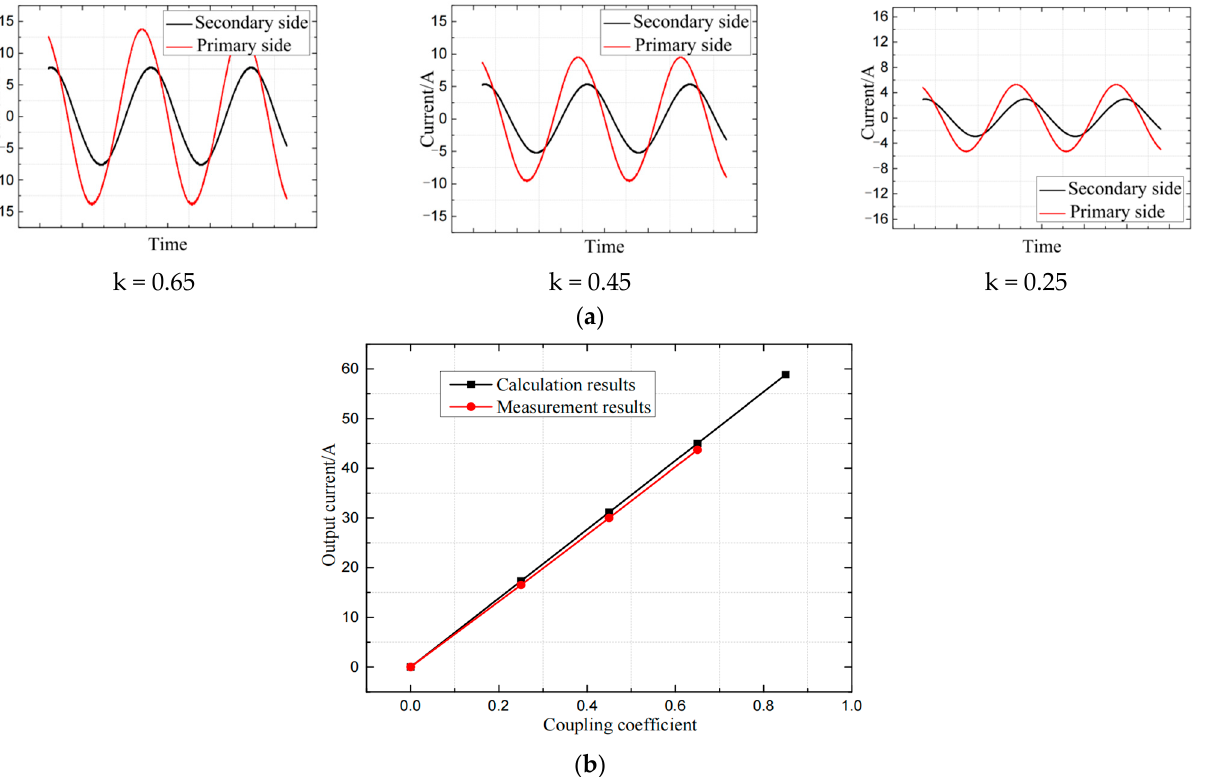
Figure 25. Comparison of experimental waveforms and theory in the case of misalignment: ( a ) Current of primary and secondary coils under different coupling coefficients; ( b ) output current comparison with offset.